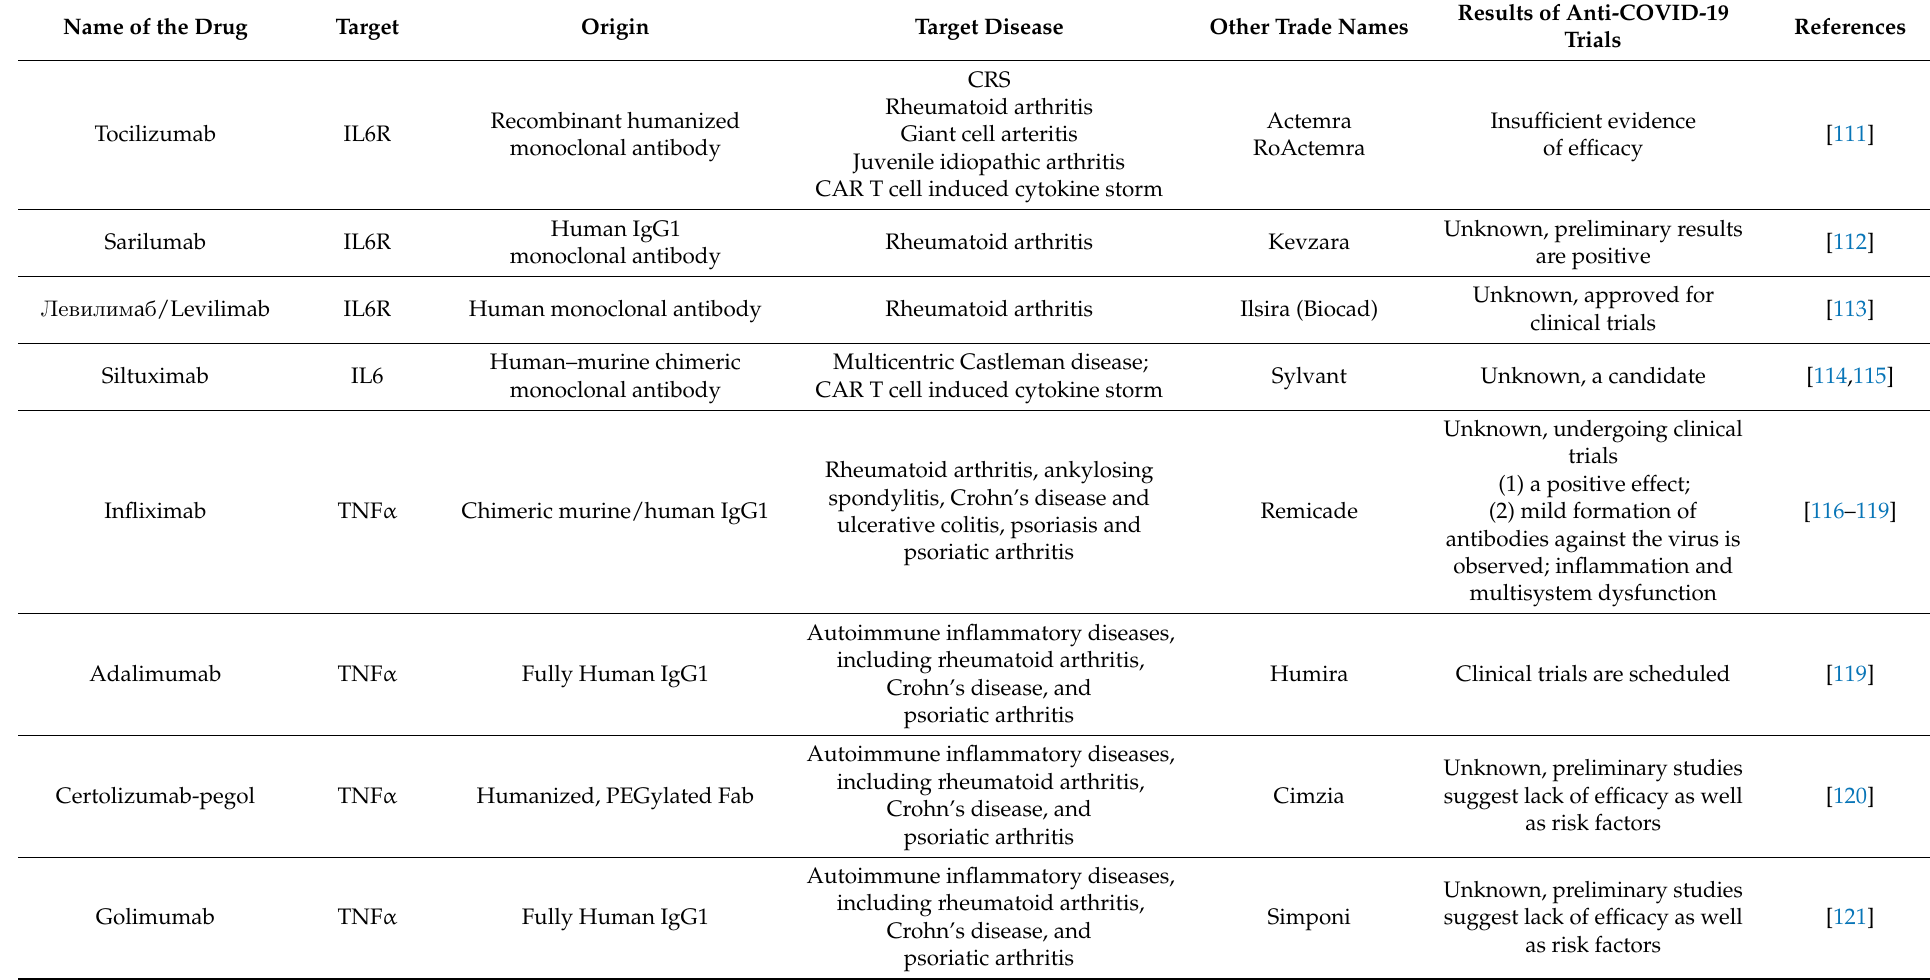
Table 2. Monoclonal antibodies approved for anti-IL6 and anti-TNF α